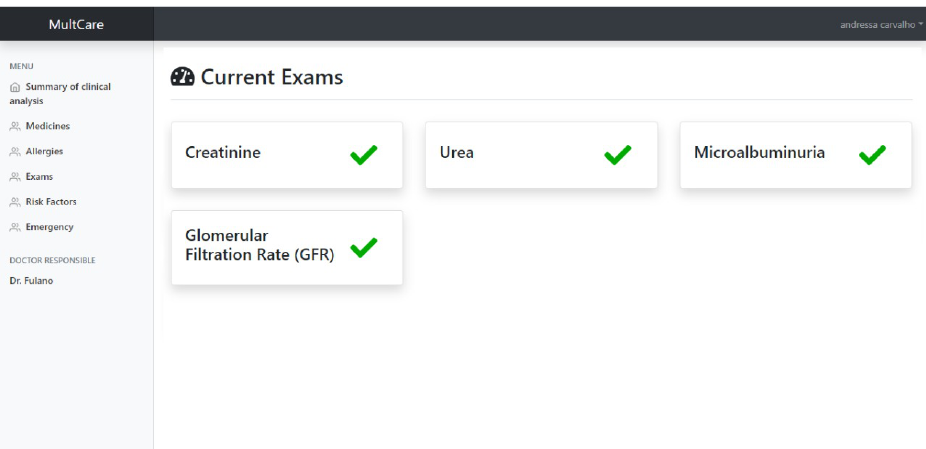
Figure 6. Screenshot of the main GUI for the patient